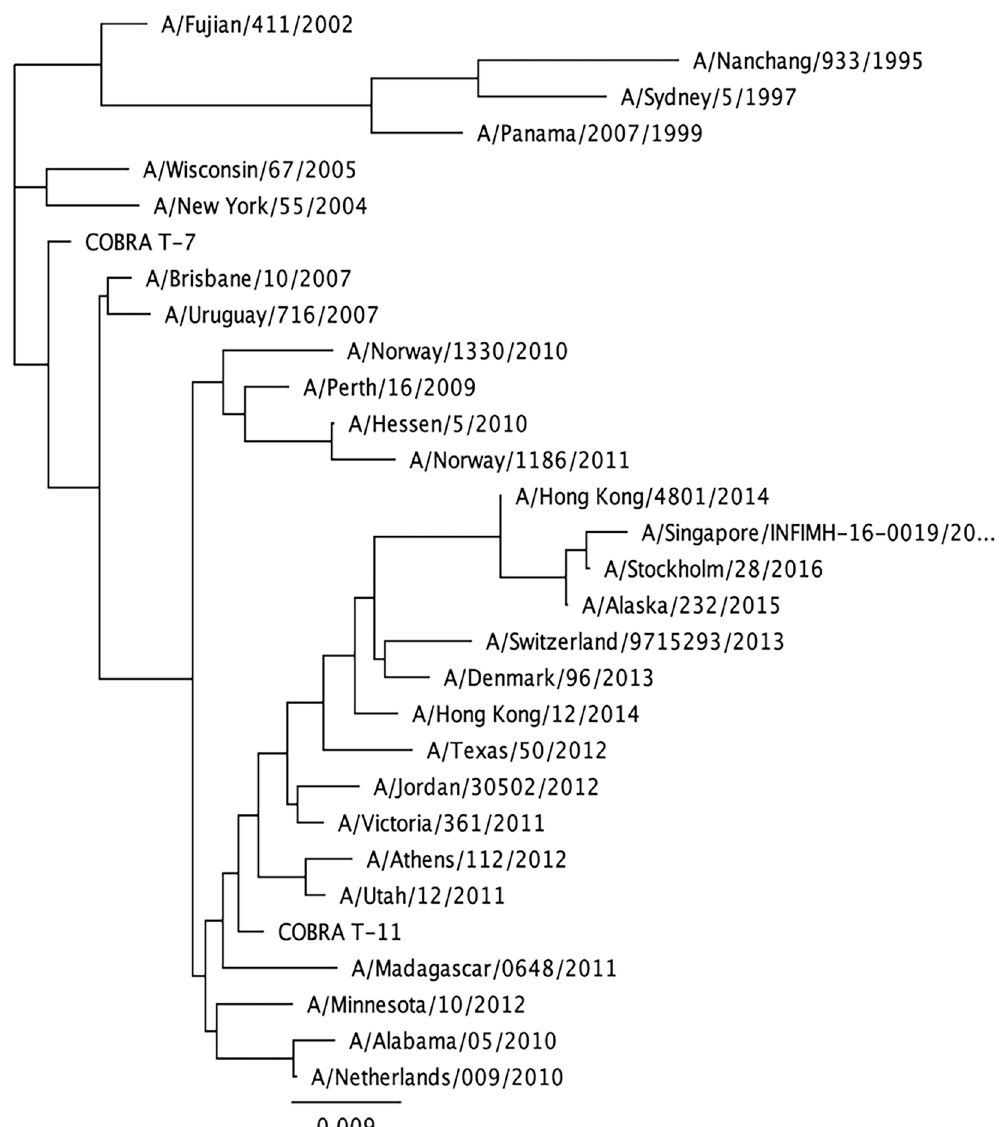
Fig 6. Phylogenetic tree of H3 HA sequences. The unrooted phylogenetic tree was inferred from HA amino acid sequences derived from 30 H3 HA and COBRA HA sequences using the maximum likelihood method. Sequences were aligned with MUSCLE 3.7 software, and the alignment was refined by Gblocks 0.91b software. Phylogeny was determined using the maximum likelihood method with PhyML software. Trees were rendered using TreeDyn 198.3 software [32].